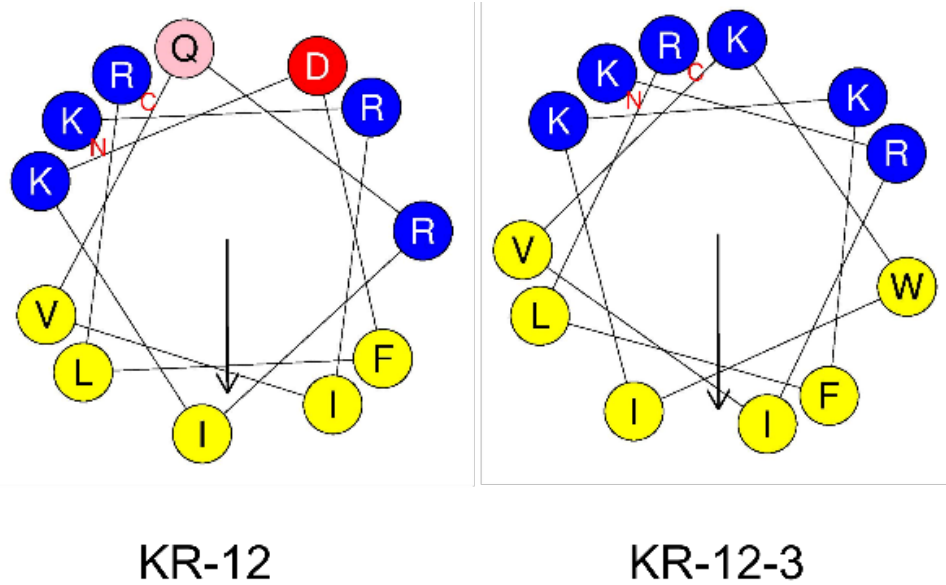
Figure 1. Sequence and helical wheel diagrams of KR-12 and KR-12-3. The down arrows represent the µ H vector. Blue circles refer to hydrophilic residues, pink circle refers to glutamine, red circle refers to aspartic acid, and yellow circles refer to hydrophobic residues. Table 3. In vitro susceptibility of S. gordonii to KR-12-3 and